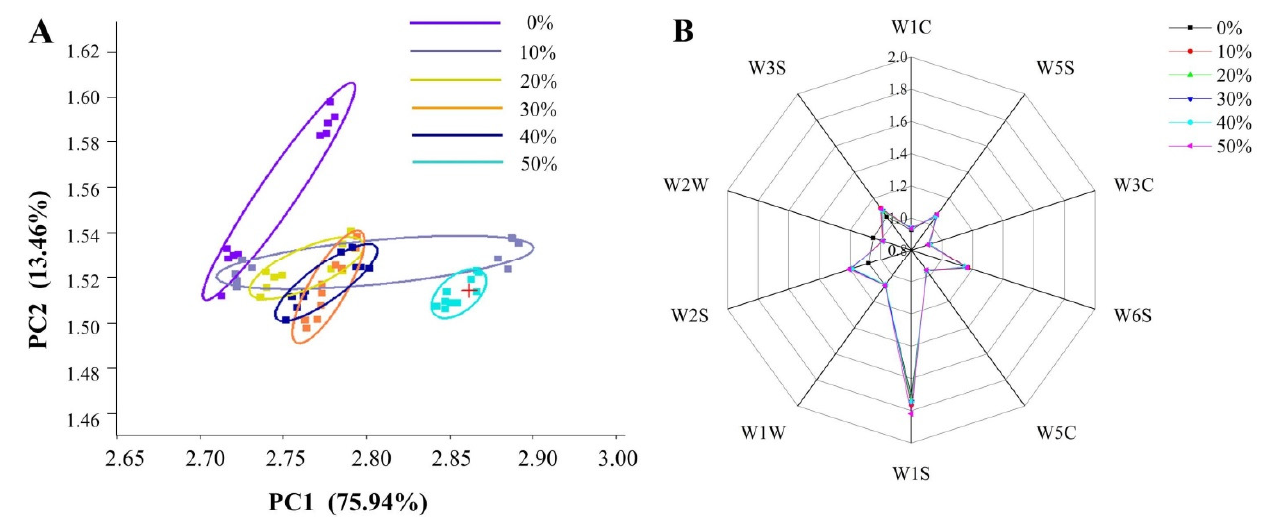
Figure 4. Effects of different SOB substitution amounts on flavor properties of ice cream, they should be listed as: ( A ) principal component analysis plot; ( B ) radar be listed as: ( A ) principal component analysis plot; ( B ) radar chart.